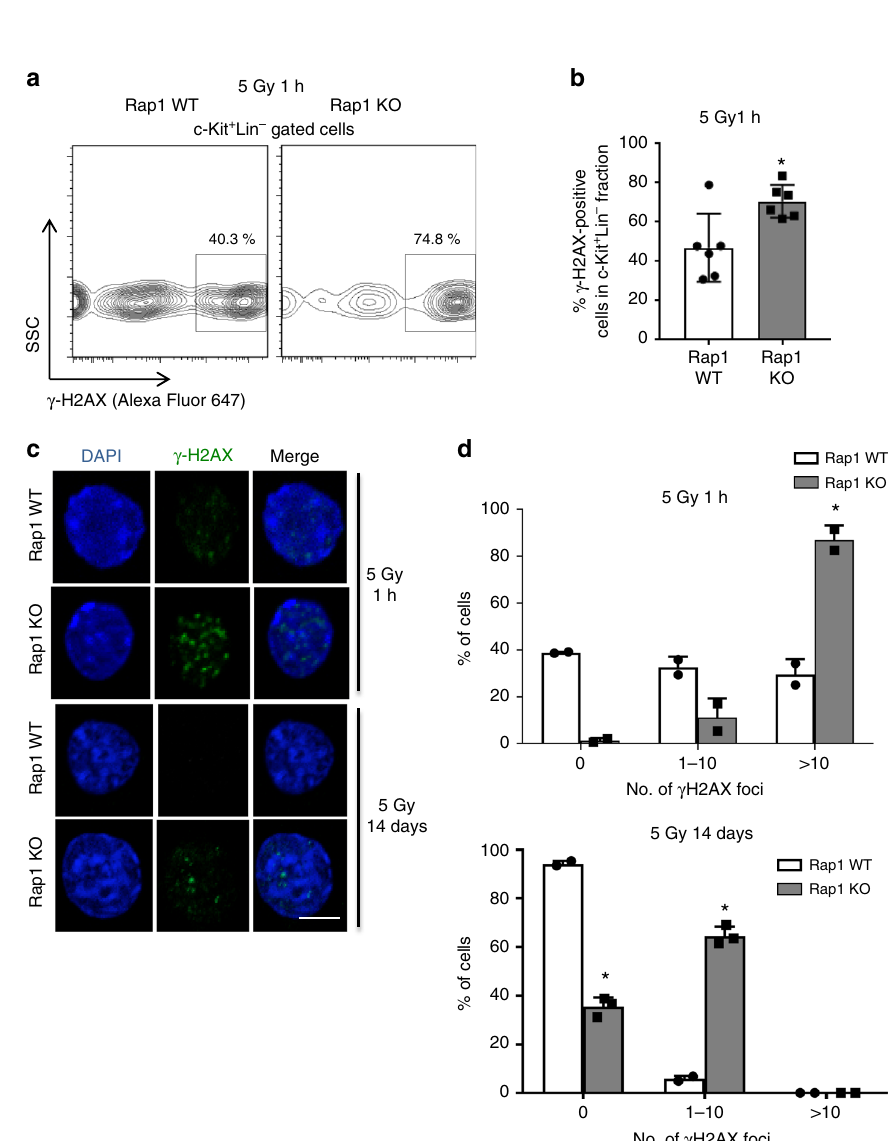
Fig. 2 Loss of Rap1 leads to genomic instability. a Flow cytometric analysis of the γ -H2AX. Representative FACS plots of 30,000 gated cells on viable c-Kit + Lin − (c-Kit positive, Lin1 negative) cells are shown. b Graphical representation of the results presented in a is shown. Mean ± SEM of the percentage of γ -H2AX-positive cells in the c-Kit + Lin - fraction. Results represented are from two independent experiments ( n = 6/genotype). * represents p < 0.05 (two- tailed Student ’ s t -test). c Representative images of the γ -H2AX staining in c-Kit + Lin − -derived cells using immuno fl uorescence staining. Scale bar, 10 μ m. d Graphical representation of the γ -H2AX-foci numbers on 1 h and 14 days after irradiation, respectively. Results of γ -H2AX-foci scoring at 1 h (left) and 14 days (right) after 5 Gy irradiation are shown. Mean ± SD of duplicate experiments is depicted. * p < 0.05 (Mann – Whitney U